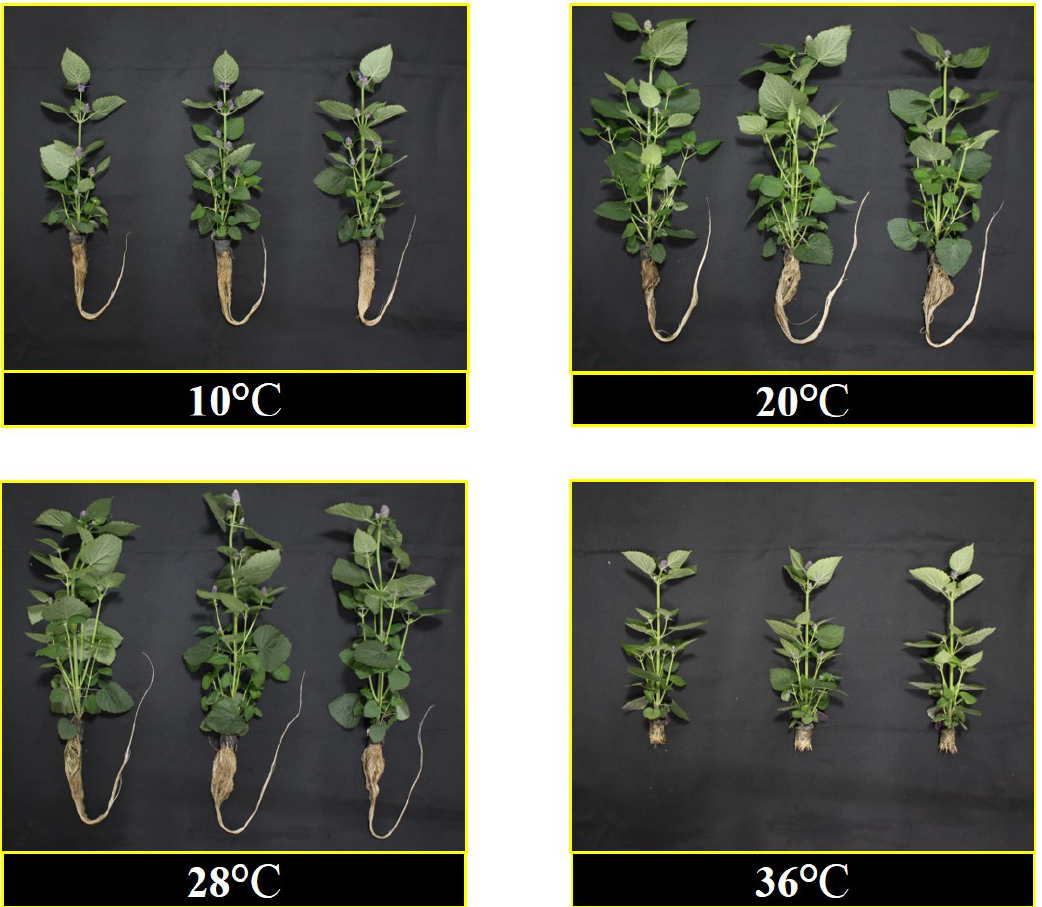
Figure 2. Images of A. rugosa plants grown at four different root zone temperature (RZT) treatments (10, 20, 28, and 36 °C) at 32 days after transplant.